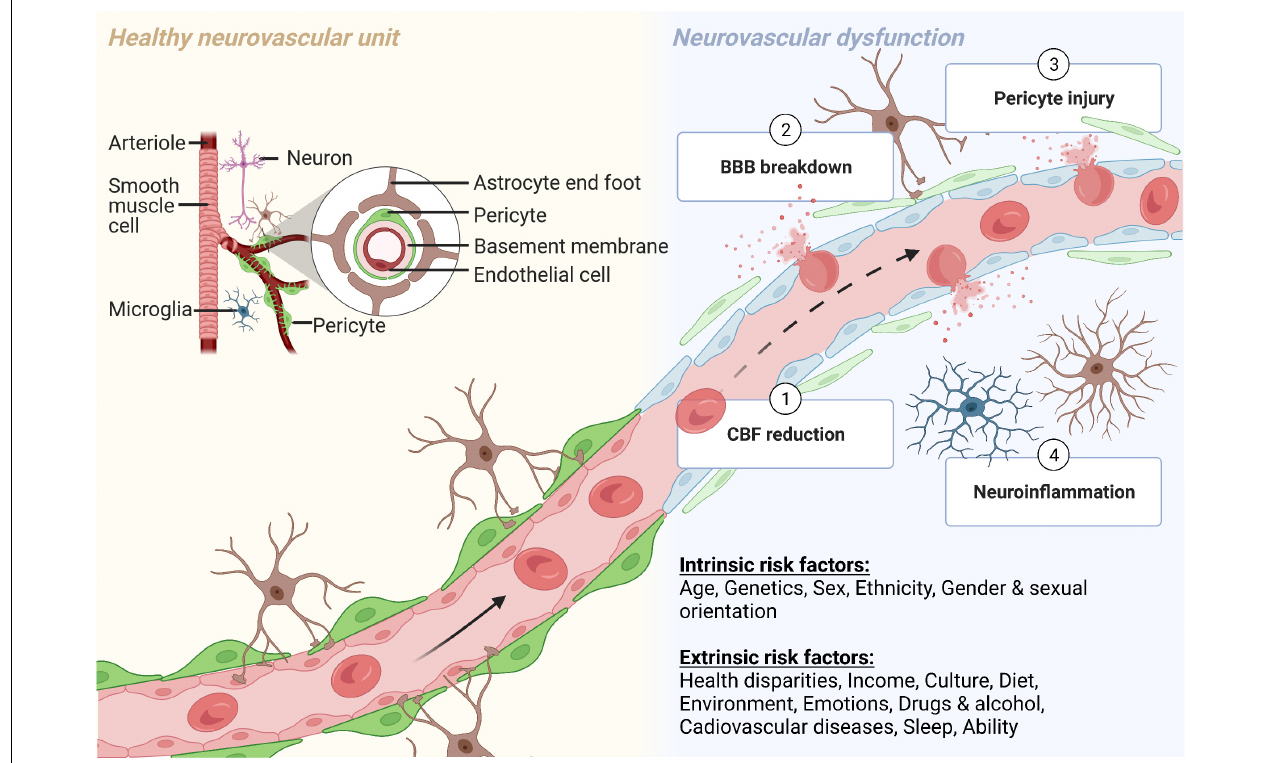
FIGURE 1 | The neurovascular unit (NVU) during normal physiological and pathological conditions. The NVU is comprised of many cell types. The blood-brain barrier (BBB) is formed by endothelial cells, which at the capillary level, are supported by pericytes. Astrocytic endfeet provide additional support to the BBB. Other cellular components of the NVU include microglia and neurons ( yellow, left side ). (1) Cerebral blood flow (CBF) reductions, (2) BBB breakdown, (3) pericyte injury, and (4) neuroinflammation all contribute to neurovascular dysfunction in many neurodegenerative diseases and disorders, including Alzheimer’s disease ( blue, right side ). Both intrinsic and extrinsic factors can contribute to neurovascular dysfunction. Created with